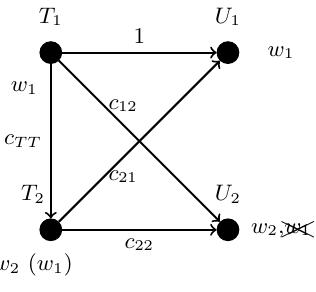
Figure 1: Cognitive channel with secrecy con-